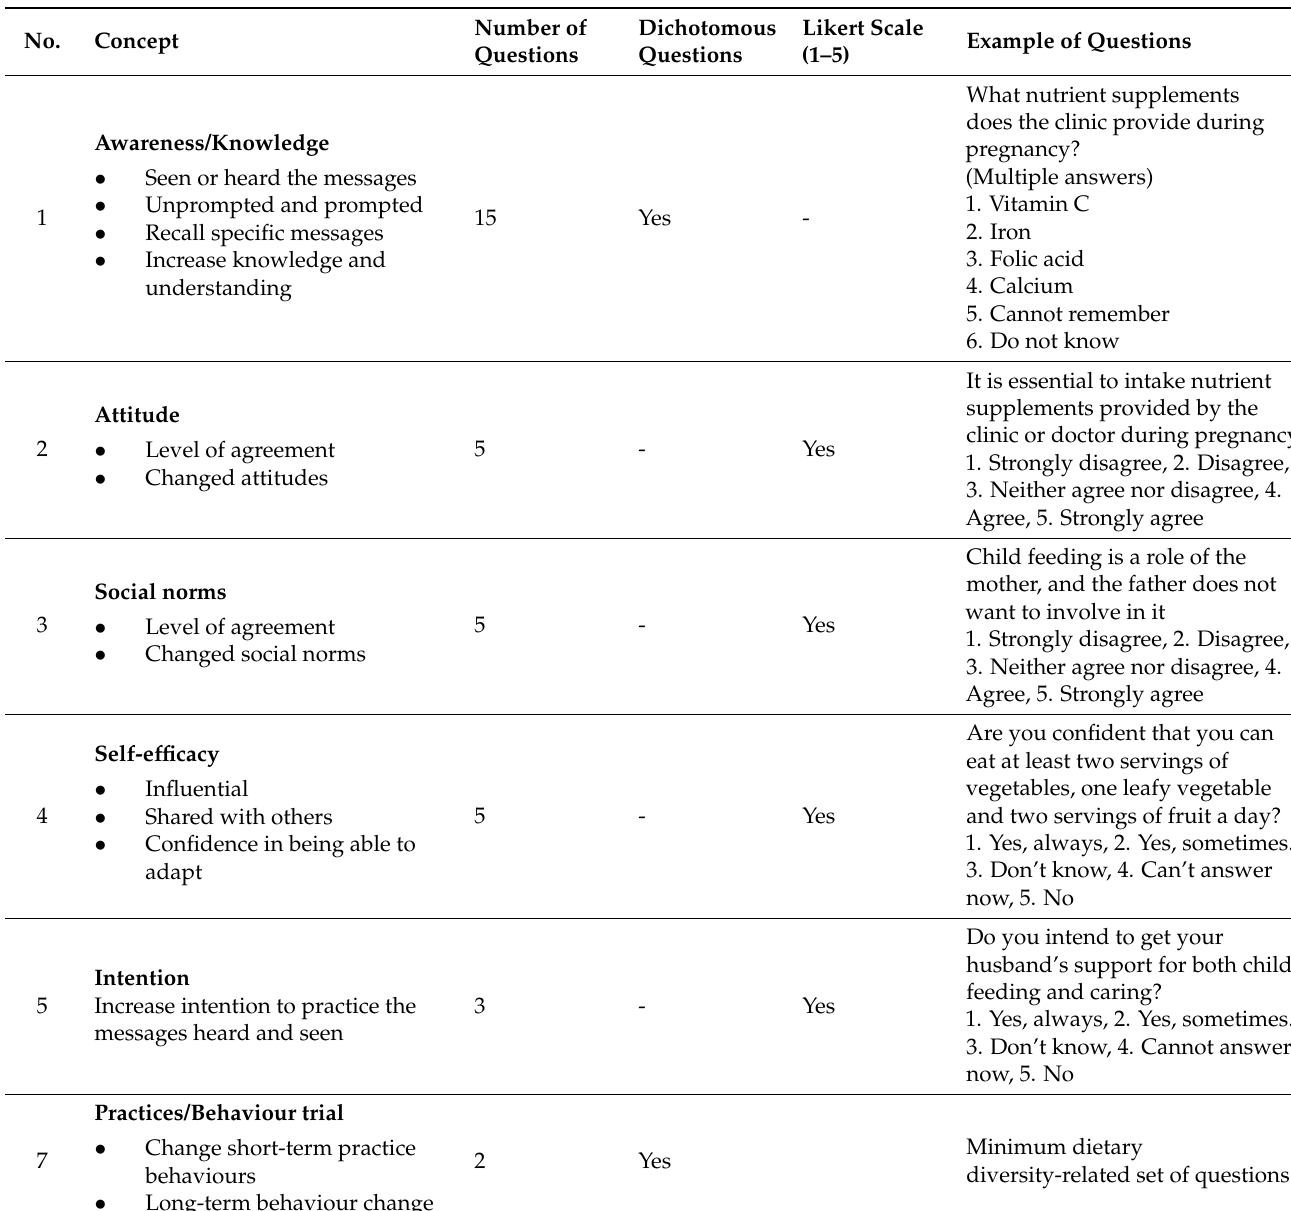
Table 1. Description of the pre- and post-test questionnaires with hierarchy of effects model